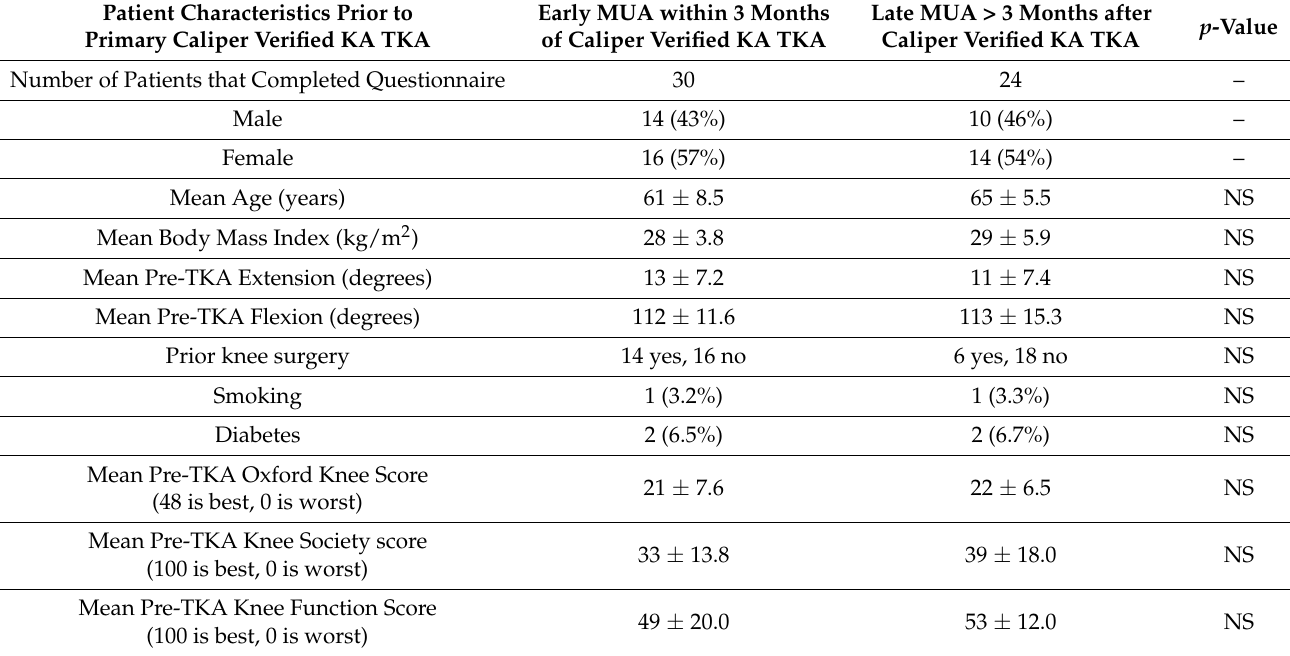
Table 1. Patient Characteristics Prior to Primary Calipered KA TKA for Patients Treated with an Early and Late Manipulation Under Anesthesis (MUA).